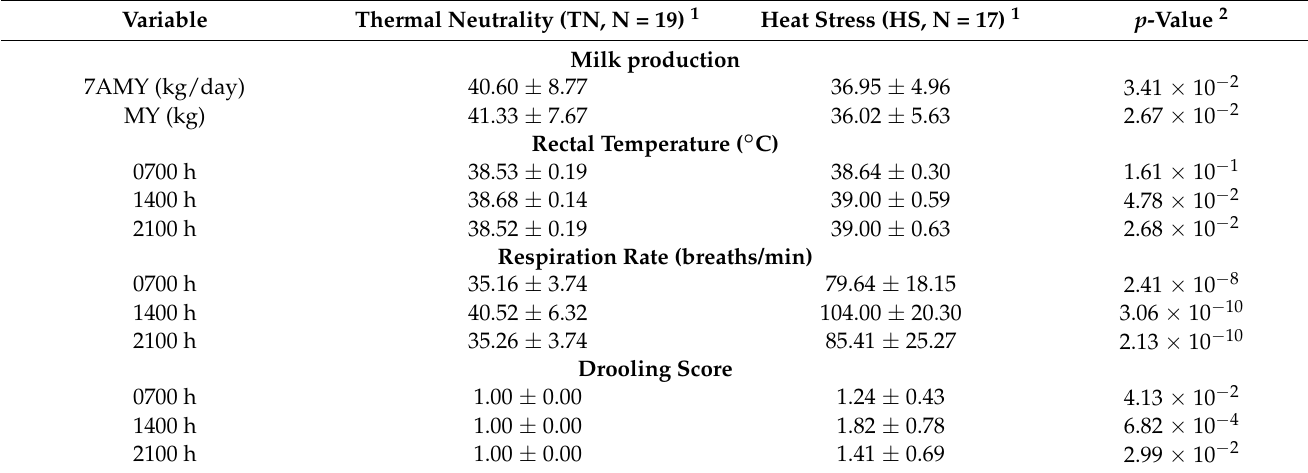
Table 1. Productive performance and physiological indicators of Holstein cows under thermal neutrality (TN) and heat stress (HS)